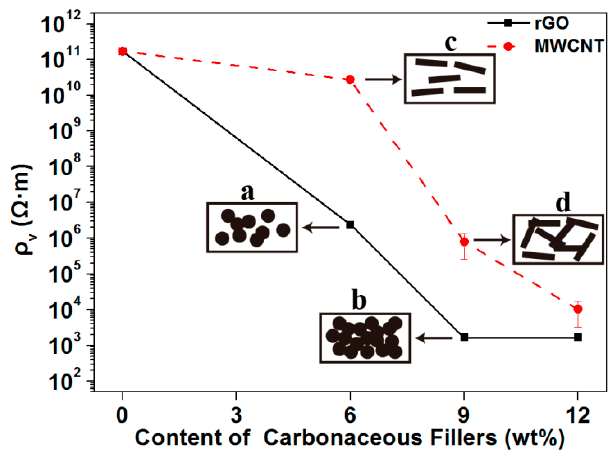
Figure 2. Volume electrical resistivity of the composites at different loadings of redox graphene nanoplatelets (rGO) or multi-walled carbon nanotubes (MWCNTs).